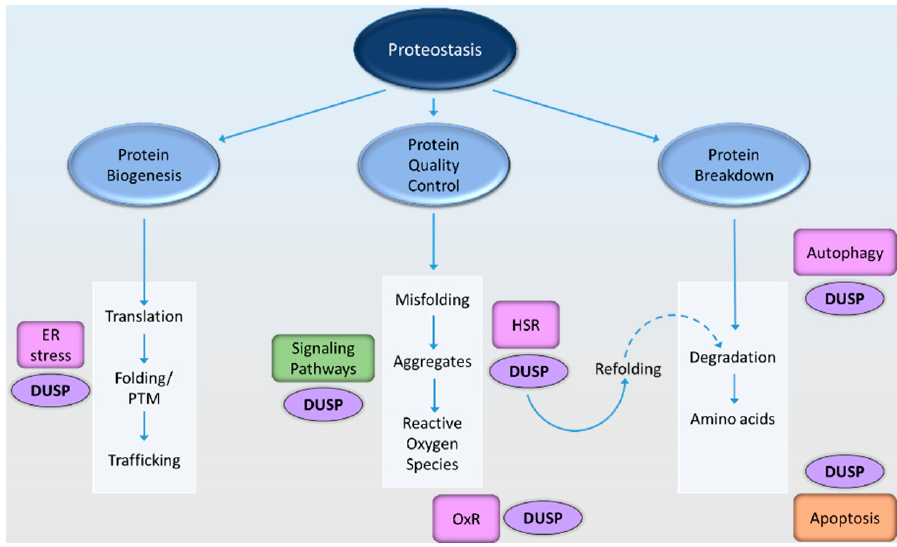
Figure 3. A proposed working model showing the involvement of DUSPs in pathways of proteostasis that contribute to neurodegeneration. A simplified version of proteostasis is represented under three central themes—protein biogenesis, protein quality control processes, and protein degradation. In this article, we highlight the role of DUSPs in protein quality control and breakdown, with respect to neurological disorders. Protein translation, folding, and transport occur largely within the endoplasmic reticulum (ER). An increased load of misfolded proteins in the ER evokes the ER stress response, and several DUSPs have been shown to participate in this pathway of proteostasis. Next, protein aggregates are the by-products of accumulated misfolded proteins and represent the hallmarks of many neurodegenerative diseases. DUSPs participate in phosphorylation-dependent modulation of protein aggregation mostly by regulating MAPK and related signaling pathways. Reactive oxygen species (ROS) production is often triggered in response to protein aggregates and results in oxidative stress. DUSPs participate in the oxidative stress response (OxR), and may have protective or aggravating roles, depending on the phosphatase. Further, DUSPs have a confirmed involvement in the heat shock response (HSR) pathway by either self-modulation or by direct interaction with the heat shock proteins/molecular chaperones. Heat shock proteins assist misfolded and aggregated proteins to refold and attain their native conformation. Proteins which fail to refold even after assistance from the heat shock response pathway, may then be degraded (indicated by dotted arrow). Finally, autophagy is the major degradation route for toxic-protein aggregates, and is known to be influenced by some DUSPs. When individual cells become overwhelmed by proteotoxic stress, they may enter apoptosis. The initiation of the apoptotic cascade is also known to be influenced by certain DUSPs.